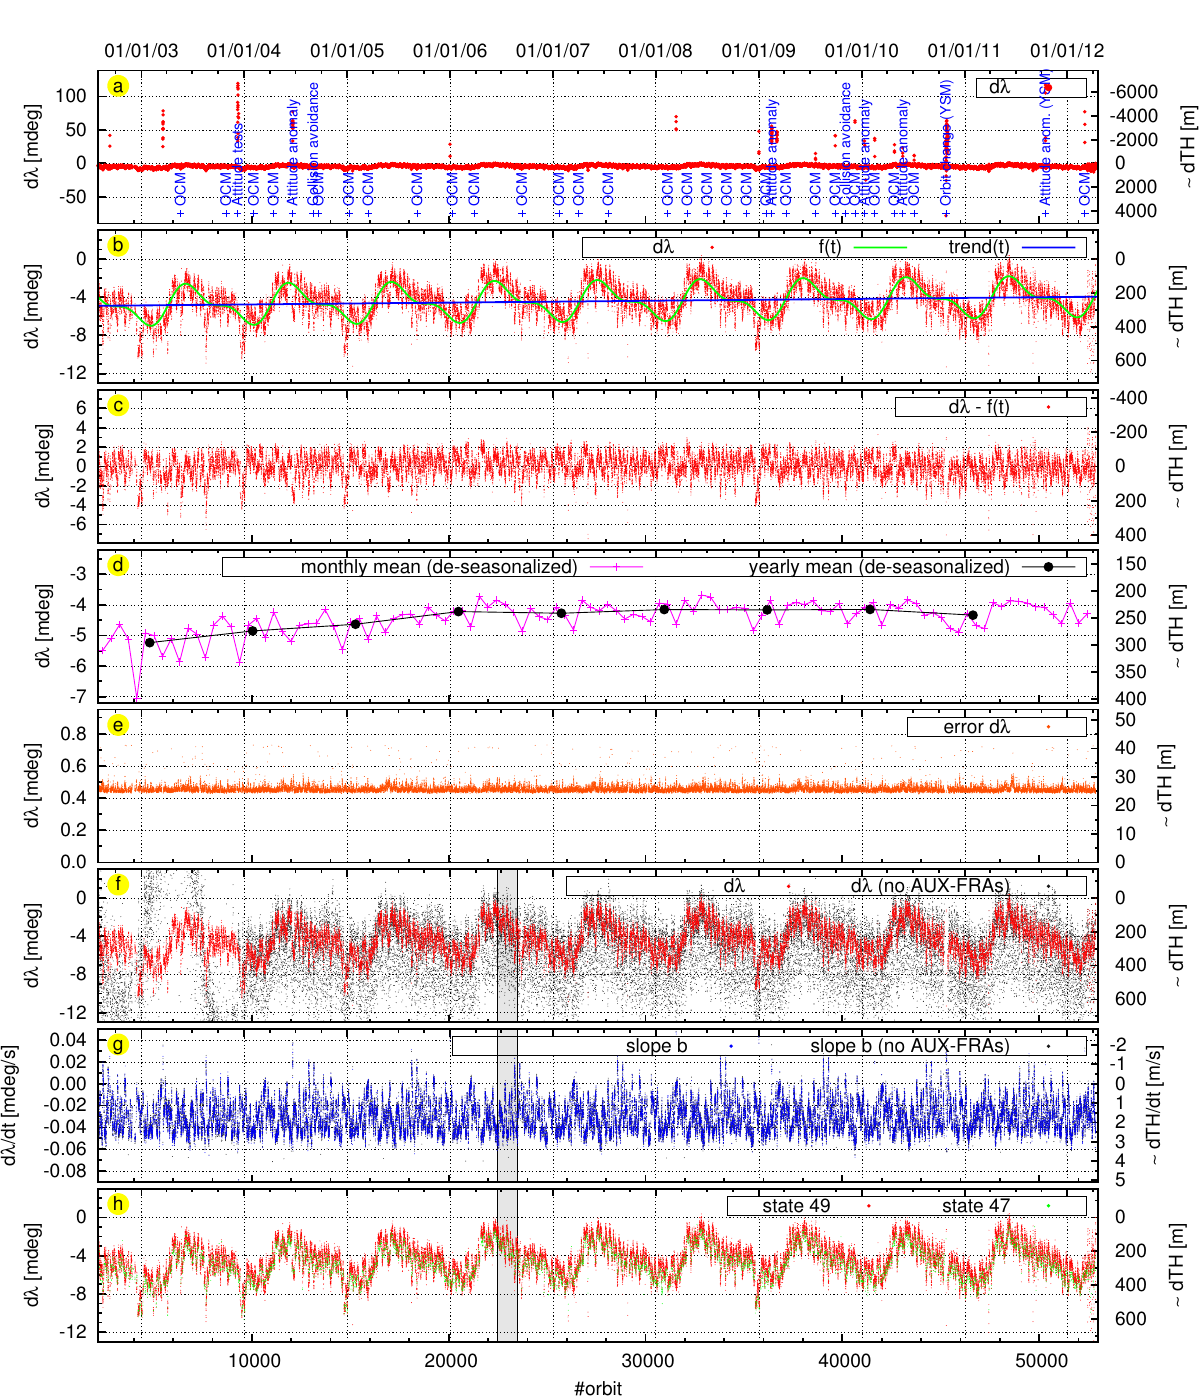
Fig. 9. Time series of fitted EAO, extrapolated to the relevant altitude ∼ 17.2km. Zooms of the gray bars in (e) , (f) , (h) are shown in Fig. 10. (a) Full range of observed EAO. The blue crosses and text mark known instrument anomalies with possible impact on pointing. (b) Zoom of (a) to the main range of observed EAO. Added are the fitted function f (t) according Eq. (4) and the linear term of f (t) (labeled trend ( t )). ( c ) The remaining day to day variation, if f (t) is subtracted from the EAO. (d) Monthly and yearly means of the EAO with the sinusoidal term of Eq. (4) subtracted. (e) Total error of the EAO. (f) The EAO with and without (gray dots) using the AUX-FRAs. (g) The slope b of the EAO with and without (gray dots) using the AUX-FRAs. (h) EAO derived from state 47, compared to the usual ones from state